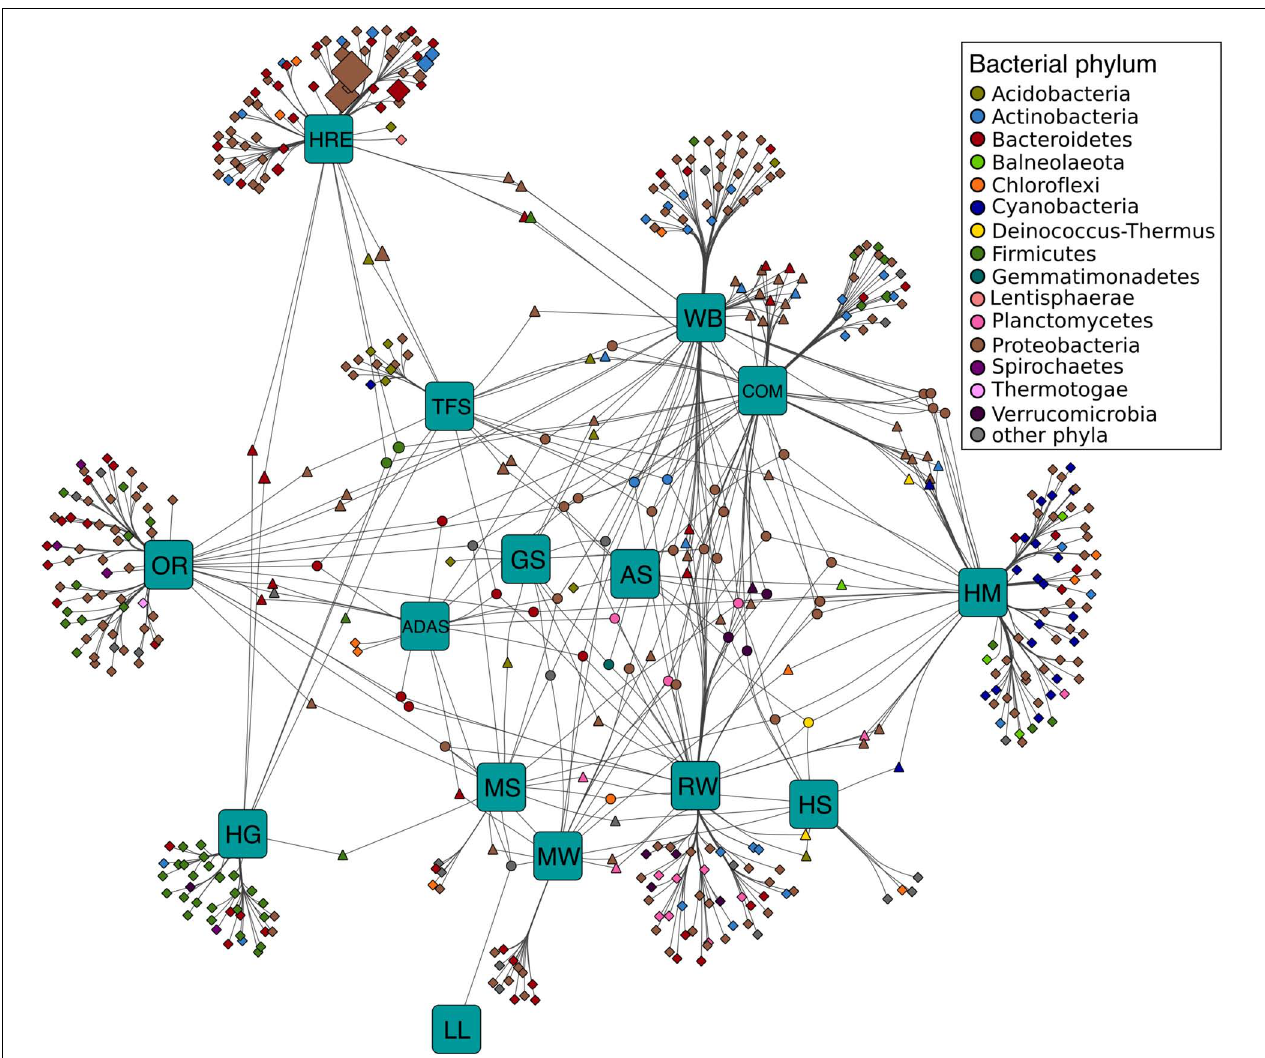
FIGURE 5 | Association networks between bacterial origin of assigned PLPs at genus level and habitats. The abundance of PLPs in each genus per sample was presented by LPGM values, and only genera with mean LPGM values of ≥ 0.5 across all the samples were used. Source nodes (rounded squares) represent habitats, target node represent bacterial genera (circles, diamonds, and triangles), and edges represent associations between habitats and bacterial genera. Target node size represent its mean abundance inferred from LPGM values across habitats. Target node is colored according to its phylogenetic origin at phylum level. The length of edges is weighted according to association strength. Unique clusters, which associate with only one habitat, consist of nodes shaped as diamond. Triangle and circle nodes represent genera with significant cross association between two and more habitats, respectively. Data only represents genera that showed significant positive association with habitats ( P = 0.05). For ease of visualization, edges were bundled together, with a stress value of 3. Abbreviations of habitats: ADAS, anaerobic digestor active sludge; AS, agricultural soil; COM, compost; GS, grassland soil; HG, human gut; HM, hypersaline mat; HRE, hydrocarbon resource environment; HS, hot spring; LL, landfill leachate; MS, marine sediment; MW, marine water; OR, oil reservoir; RW, river water; TFS, tropical forest soil; WB, wastewater bioreactor; ELF, ESTHER lipolytic family.